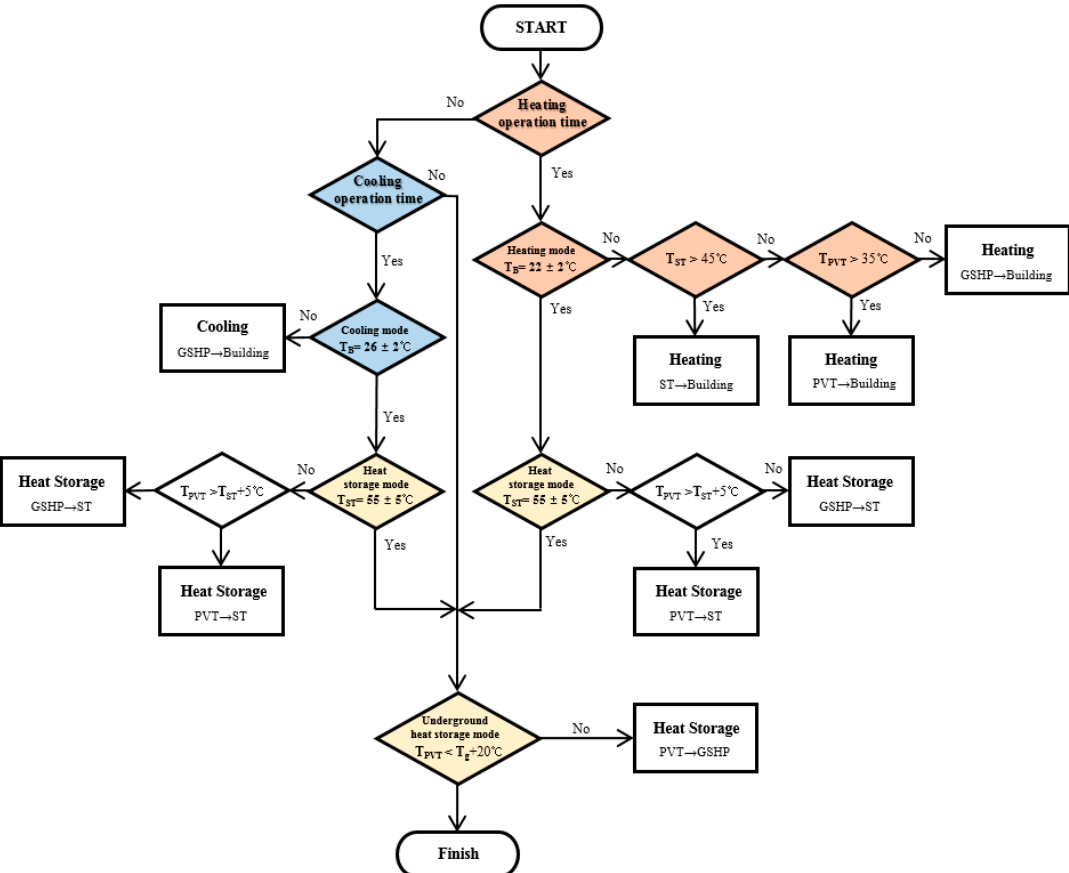
Figure 3. Control algorithm of Geo-PVT system in simulation.